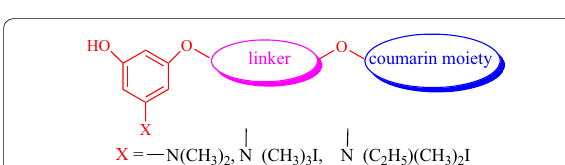
Fig. 41 General structure of the synthesized coumarin derivatives